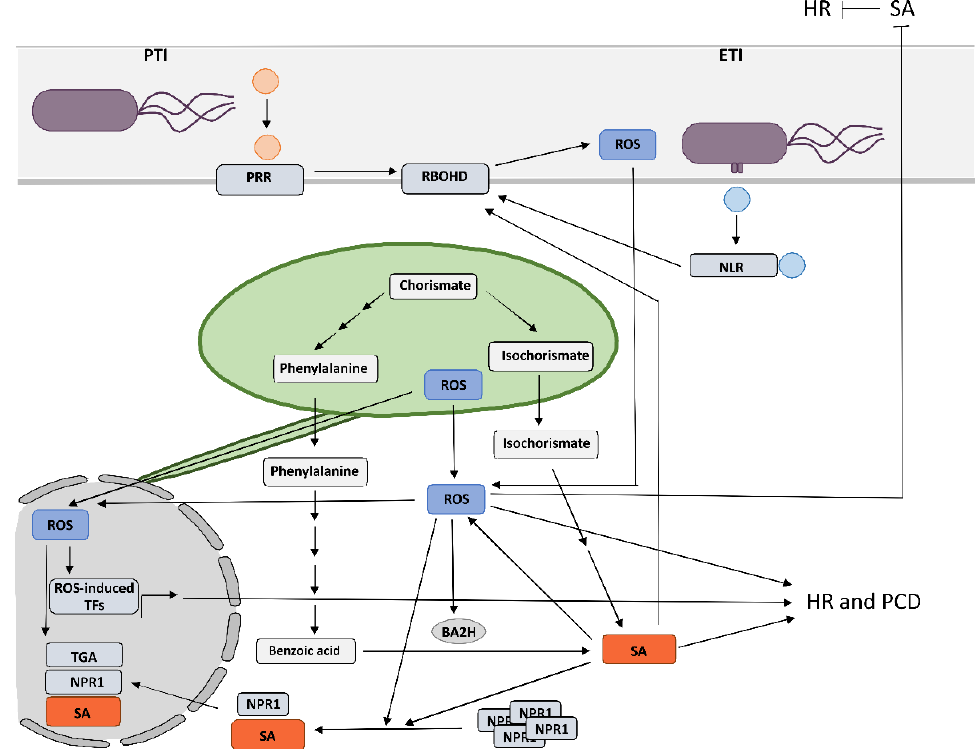
Figure 1. Intertwined roles of reactive oxygen species and salicylic acid signaling in plant response to biotic stress. The scheme represents the crosstalk between salicylic acid (SA) and reactive oxygen species (ROS) signaling. Pathogen-associated molecular-pattern-triggered immunity (PTI) is mediated by cell-surface-localized pattern recognition receptors (PRRs), which recognize conserved microbial- or pathogen-associated molecular patterns (MAPMs or PAMPs) extracellularly. Intracellular-nucleotide-binding domain leucine-rich repeat receptors (NLRs) detect pathogen effector proteins within cells and activate effector-triggered immunity (ETI). Successful ETI often results in hypersensitive response (HR)-conferred resistance and programmed cell death (PCD). The role of RBOHD has been shown in both PTI and ETI. For simplicity, bacterial pathogen induces NLR on the scheme; however, the role of RBOH-generated ROS in HR cell death and/or HR-conferred resistance has also been confirmed for viral, oomycete, and fungal pathosystems. Superoxide produced by NADPH oxidases (RBOH) is spontaneously or by superoxide dis-mutase (SOD) converted to hydrogen peroxide (H 2 O 2 ), which crosses plasmalemma via free diffusion or aquaporin-facilitated diffusion to enter the cell. SA is known as a chief regulator of ROS production by regulating RBOH transcription. Plants possess isochorismate synthase and phenylalanine ammonia-lyase pathways to synthesize SA, both starting from chorismate precursor. Benzoic acid is converted into SA by BA2H, which is regulated by ROS. Higher SA level and change of redox state induce monomerization of NPR1, translocation into the nucleus, and NPR1-dependent gene expression through direct interactions with TGA transcription factors. Intercellular ROS inhibits SA accumulation and HR in the adjacent cells. Chloroplastic ROS might, in addition to signaling in HR cell death, also be involved in controlling plant immune responses by reprogramming transcription of genes involved in response to pathogen attack as one of the retrograde signals either directly via stromules or by first entering the cytosol. In the nucleus, control of gene expression depends mainly on the activity of TFs that interact with oxidative-stress-responsive cis-regulatory elements within the gene promoters. The intertwined roles of ROS and SA in immunity are pathosystem- and RBOH-isoform-dependent; however, note that the scheme is simplified. SA: salicylic acid, ROS: reactive oxygen species, RBOHD: respiratory burst oxidase homolog (RBOH) NADPH oxidases D, BA2H: benzoic acid 2-hydroxylase, NPR1: nonexpresser of PR gene 1, TFs: transcription factors.